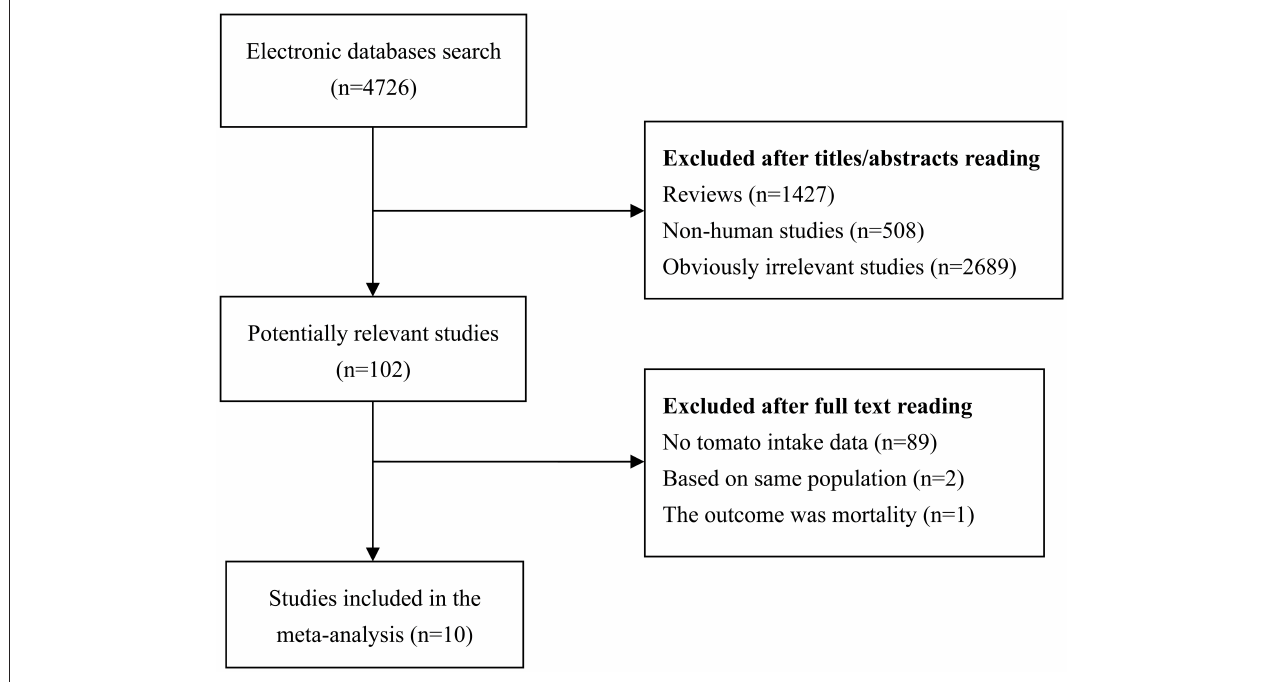
FIGURE 1 | A systematic literature search and